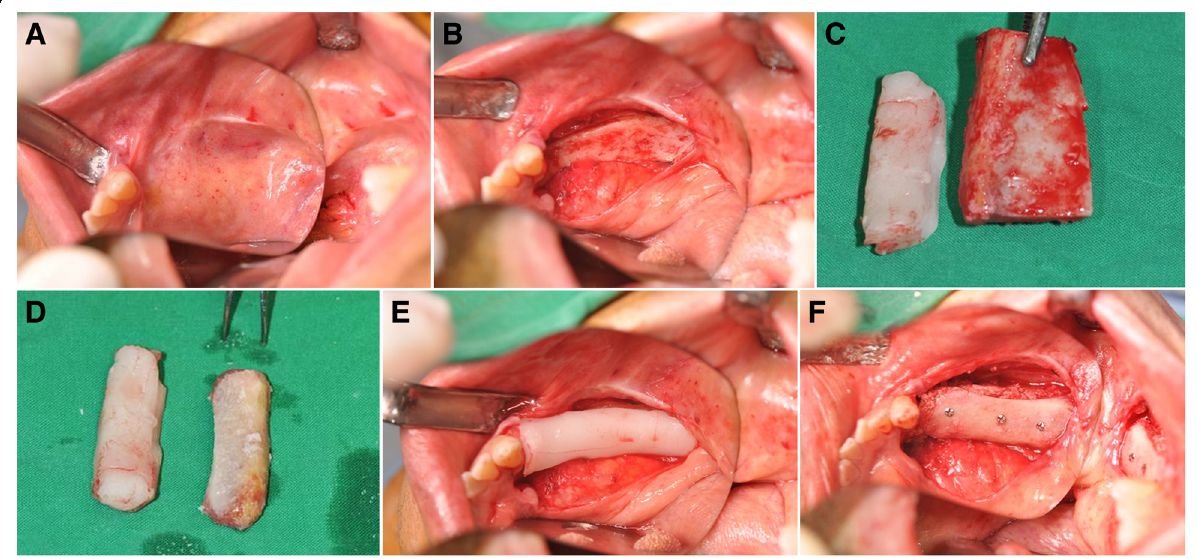
Fig. 2 Clinical views of patient no. 07 during the bone graft stage showing pre-operative view of the right edentulous posterior region of the mandible ( a ), elevation of a full thickness mucoperiosteal flap to expose the deficient edentulous area ( b ), the iliac bone block was modeled to obtain precise adaptation to the recipient region ( c , d ), and iliac bone block was fixed to the basal bone using titanium microscrews ( e , f ). All gaps between bone blocks were filled with autogenous particulate